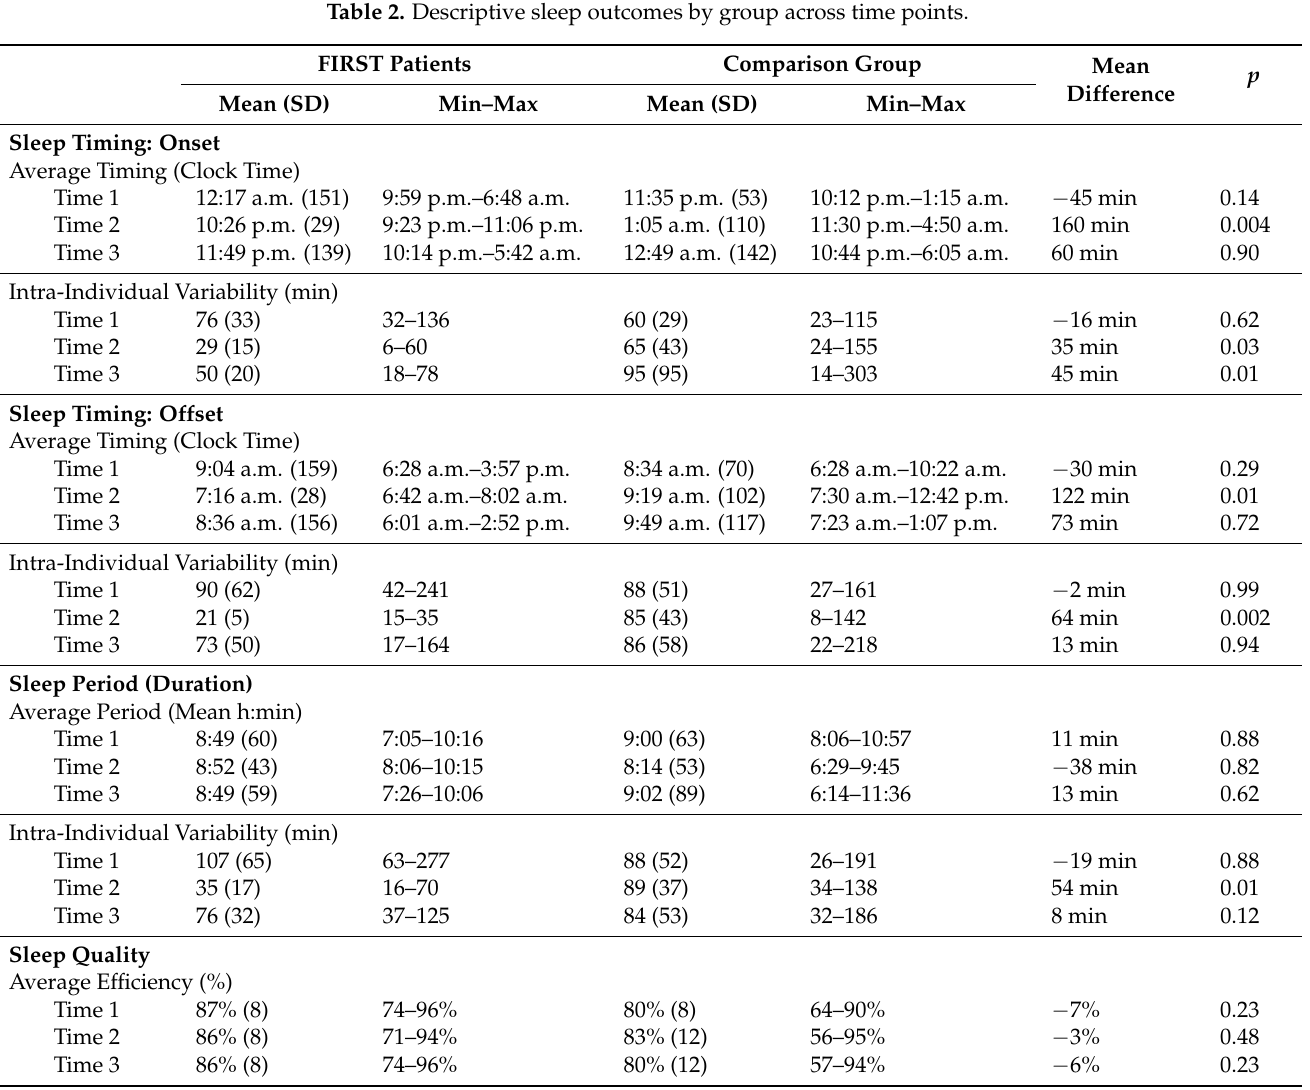
Table 2. Descriptive sleep outcomes by group across time points. FIRST